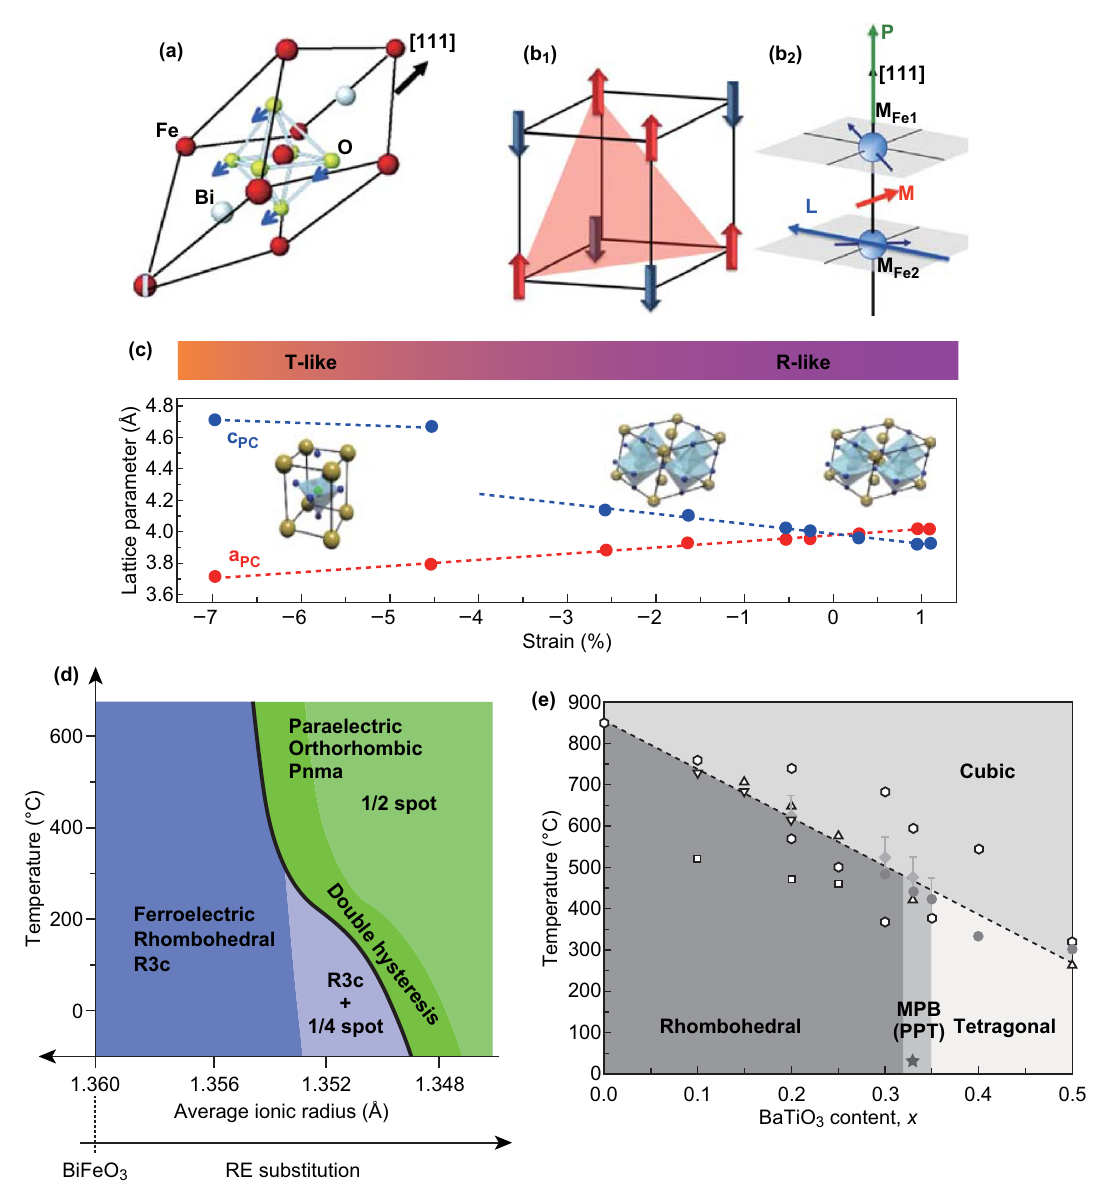
Fig. 2 Structures of BFO and factors which influence the structure. a Schematic of structures of BFO unit cells. Adapted with permission from Ref. [7]. b 1 Schematic of a G‑type antiferromagnet. Spins are ferromagnetically aligned in the (111) plane, b 2 schematically illustrating that the weak magnetization induced by canting spin cycloid structure. Adapted with permission from Ref. [95]. c Lattice parameters of BFO crystal structures with different strains in thin films. Adapted with permission from Ref. [71]. d Proposed phase diagram for rare earth‑substituted BFO thin films. Adapted with permission from Ref. [46]. e Phase diagram of the BFO–BTO system. Adapted with permission from Ref.